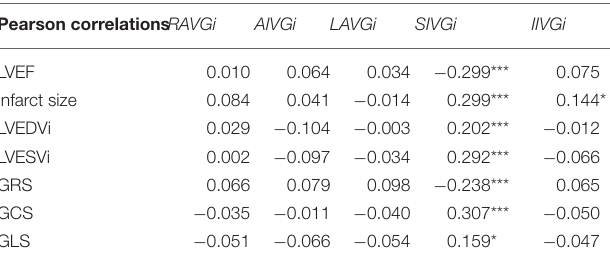
TABLE 2 | The bivariate Pearson’s correlations between pericoronary adipose tissue (PCAT) thickness index and left ventricular ejection fraction (LVEF),